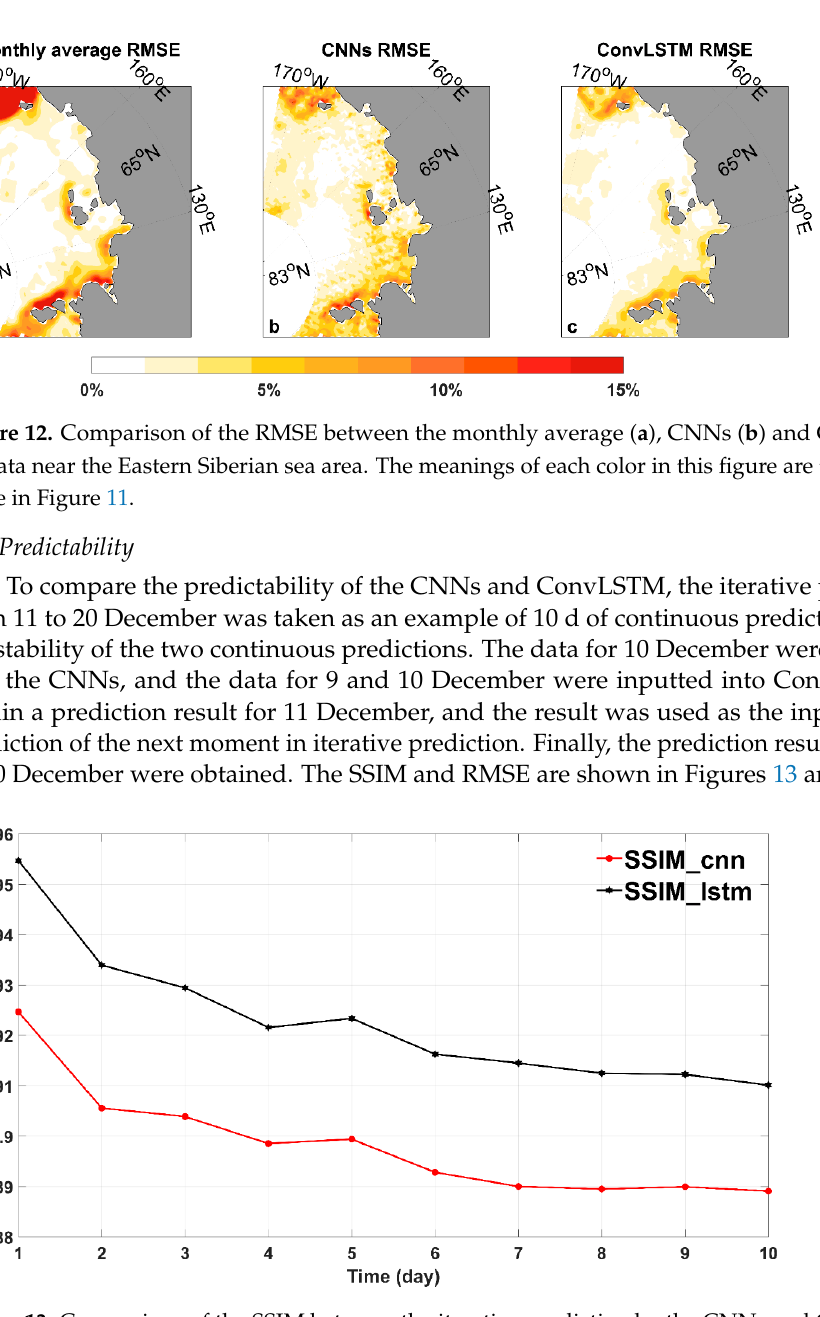
Figure 12. Comparison of the RMSE between the monthly average ( a ), CNNs ( b ) and ConvLSTM ( c ) data near the Eastern Siberian sea area. The meanings of each color in this figure are the same as those in Figure 11.